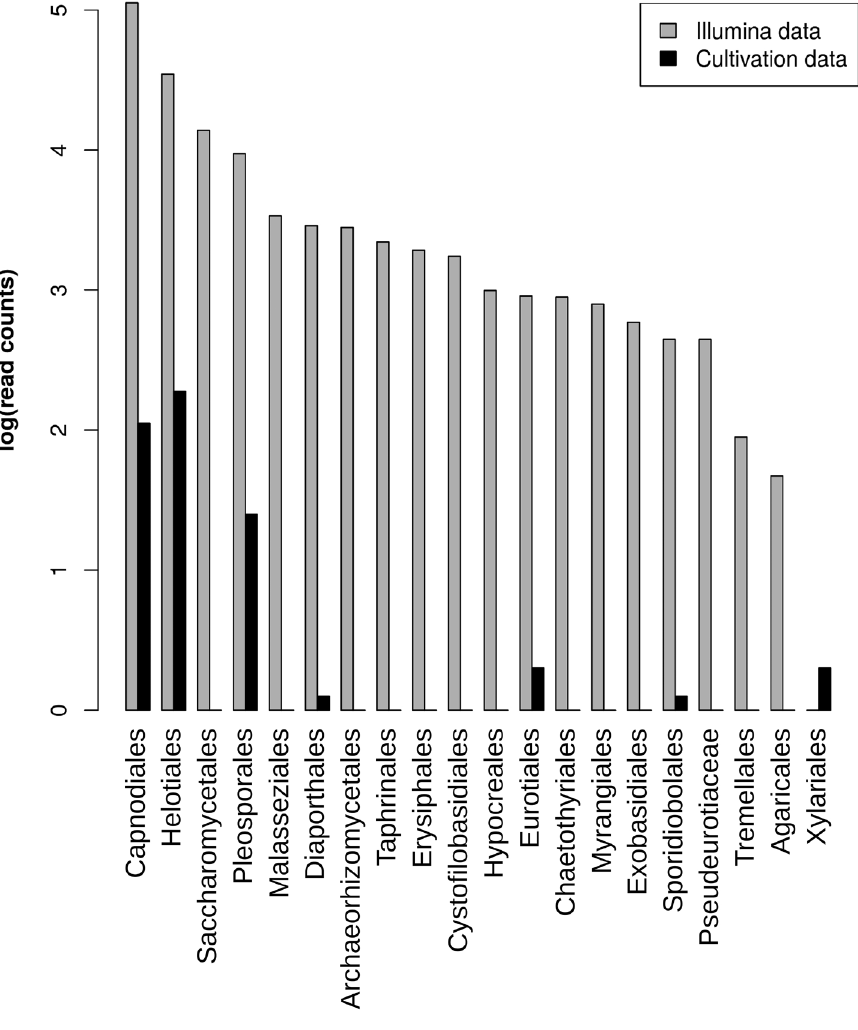
Figure 3. Abundance distribution of the 20 most abundant orders of fungal leaf-inhabiting endophytes of beech on a logarithmic scale. Three of the five most abundant orders from high-throughput sequencing were also most abundant in cultivation